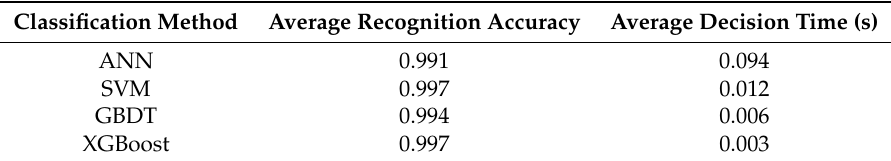
Table 5. Comparison of degradation state recognition